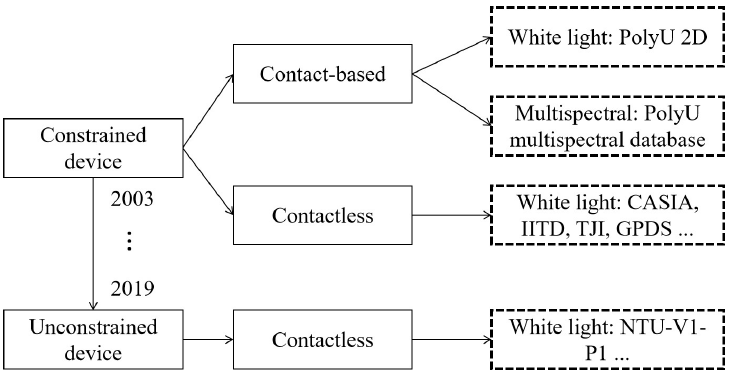
Figure 3. The brief overview of acquirement for different types palmprint databases.